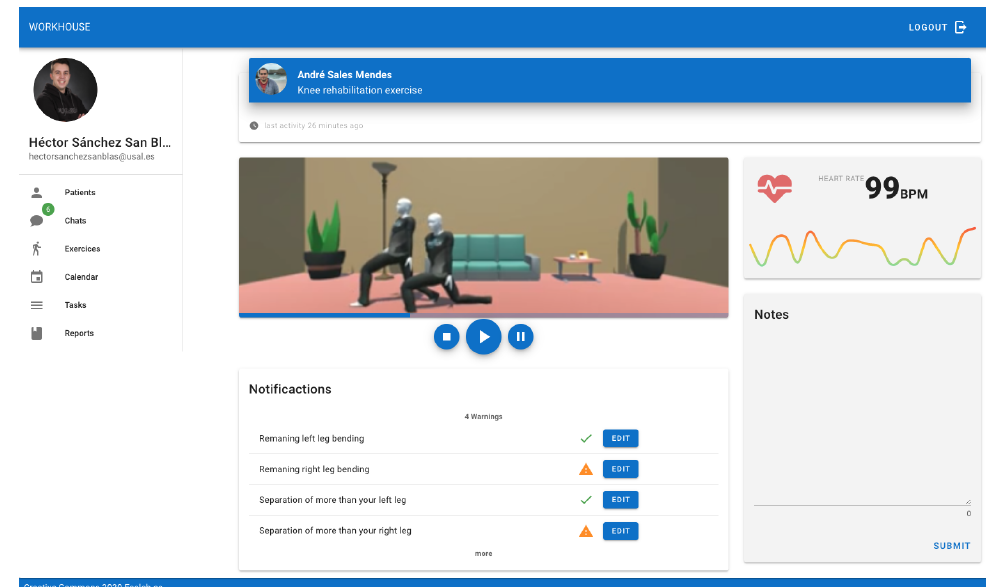
Figure 9. Information